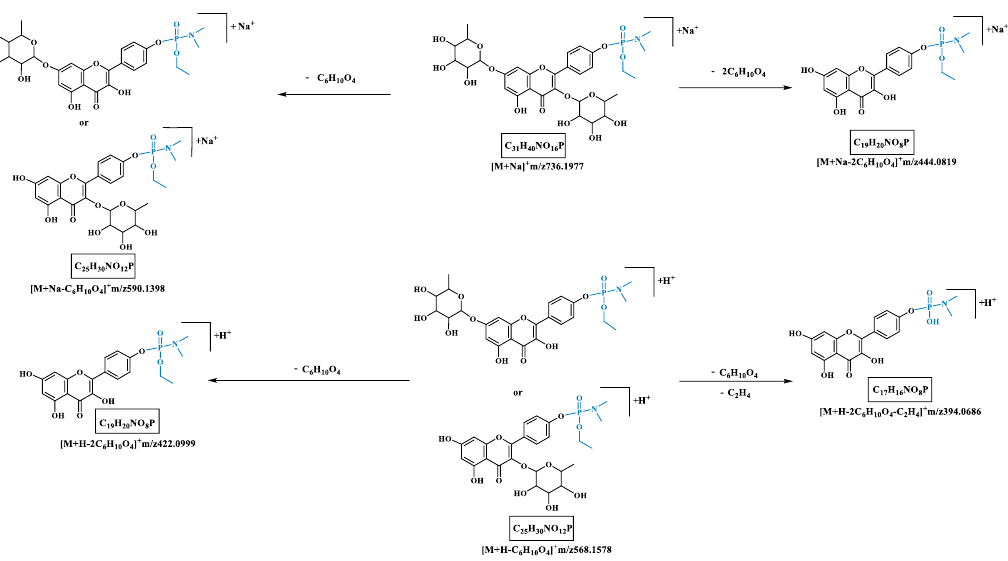
Figure 11. Possible fragmentation pathways of product ions for compound 6.